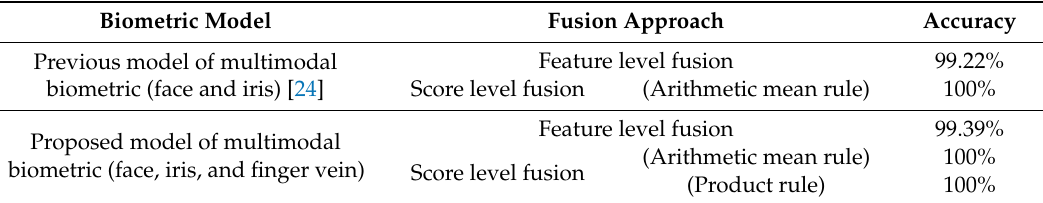
Table 2. Accuracy results using the multimodal biometrics